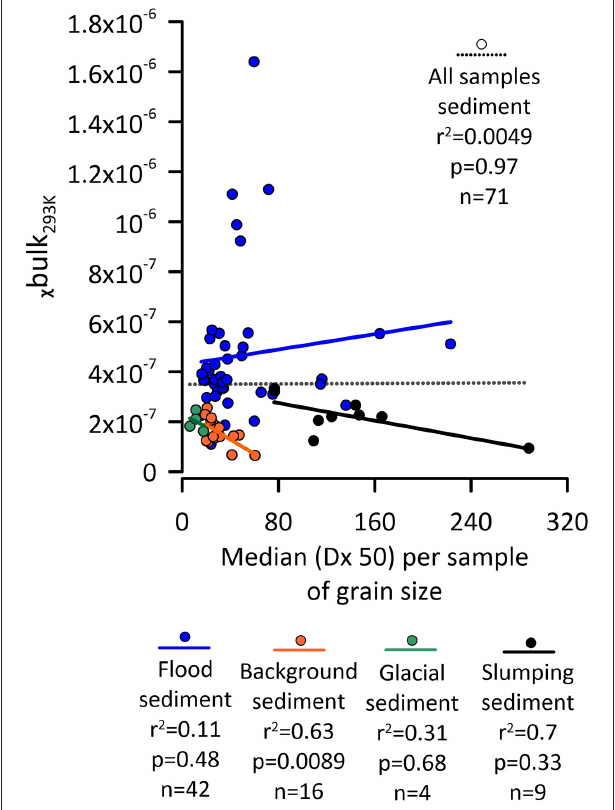
FIGURE 7 | Correlation of the full grain size dataset vs. χ bulk measurements at room temperature (293K) indicates that magnetic susceptibility (MS) does not depend on grain size. Investigating the sedimentary classes independently, a correlation exists between the parameters for background and slumping sediments. Glacial and flood sediments do not show a significant relationship between median grain size and χ bulk 293K